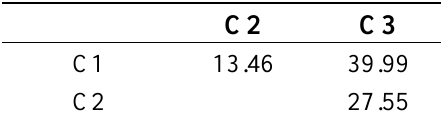
Table 4. Matrix of Euclidian distances between the final cluster centres for cluster analysis of temperature and RH